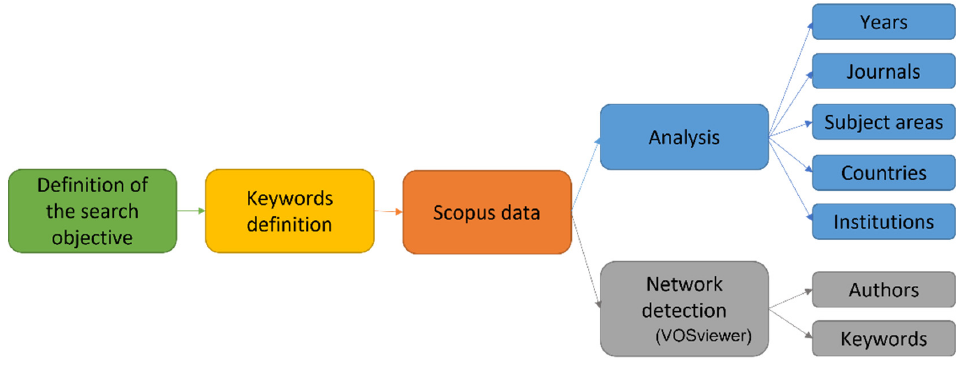
Figure 1. Workflow for the data screening and analysis.